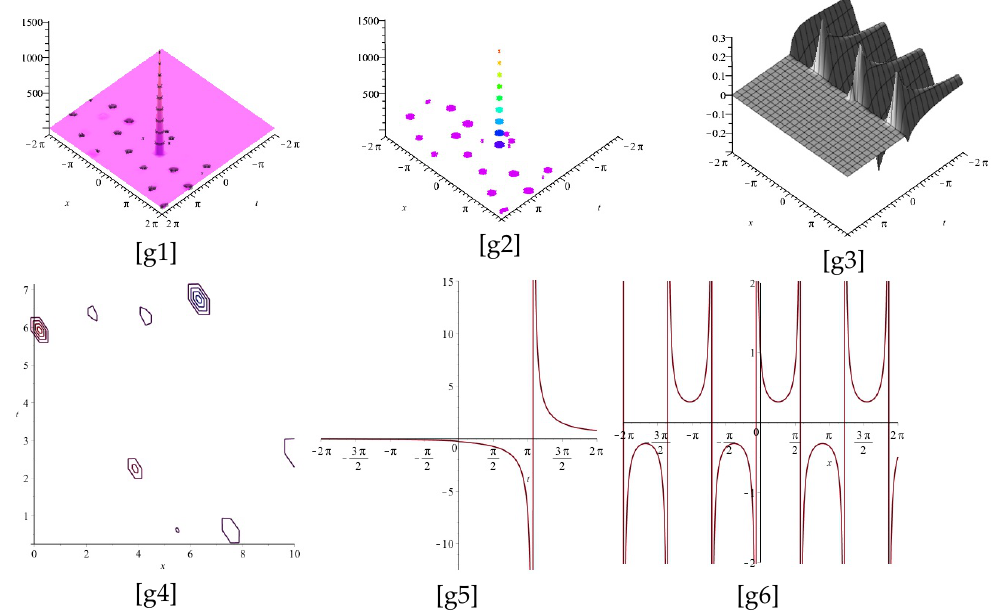
Figure 7. The plots of Equation (30), for λη > 0 and α = 0.25. Now, [g1] and [g3] are imaginary and real parts of Equation (30), and [g2], [g4], [g5], and [g6] display the z -axis orientation, the contour plot, the 2d for x = 2, and the 2d for t = 2, of the imaginary part of [g1], respectively.